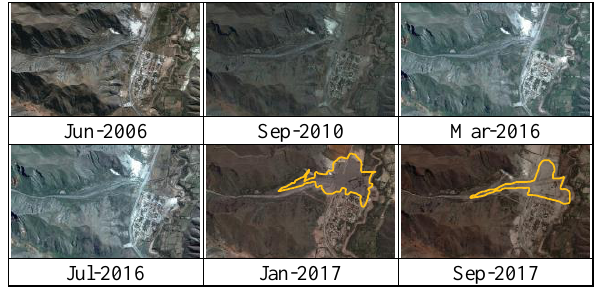
Figure 1. Evolution of Area in time This phenomenon affected 90% of the houses of the town in varying degrees as show in Table